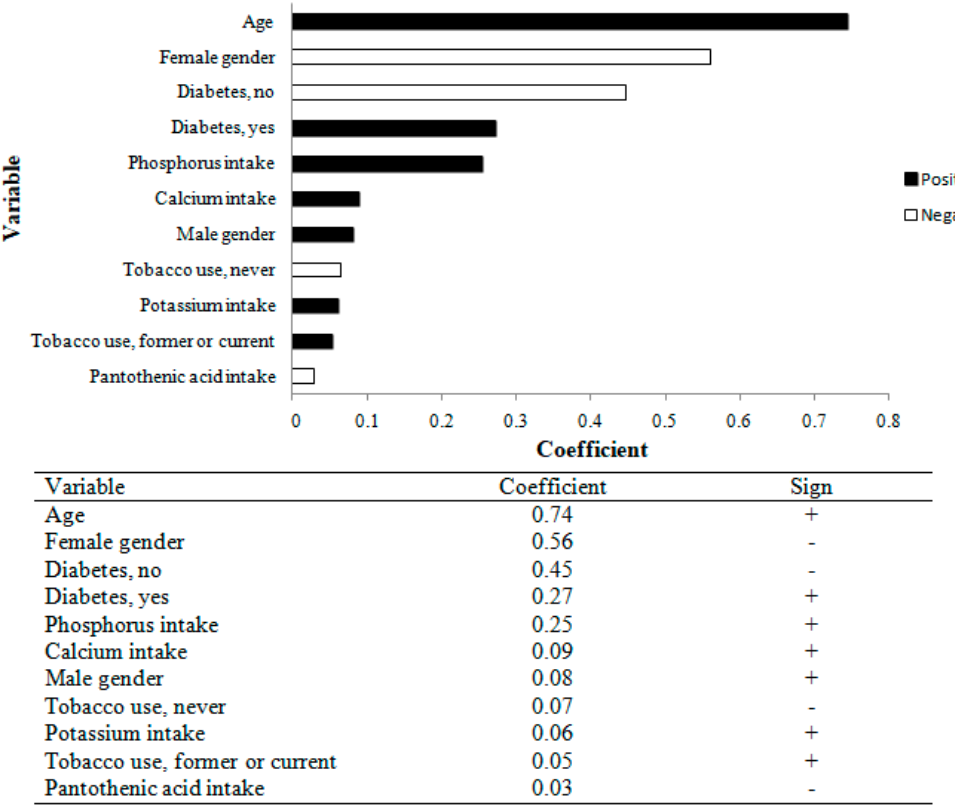
Figure 1. LASSO regression using sociodemographic and clinical variables, and nutrient intake, and CAC among PROGREDIR study participants. CAC, coronary artery calcification.